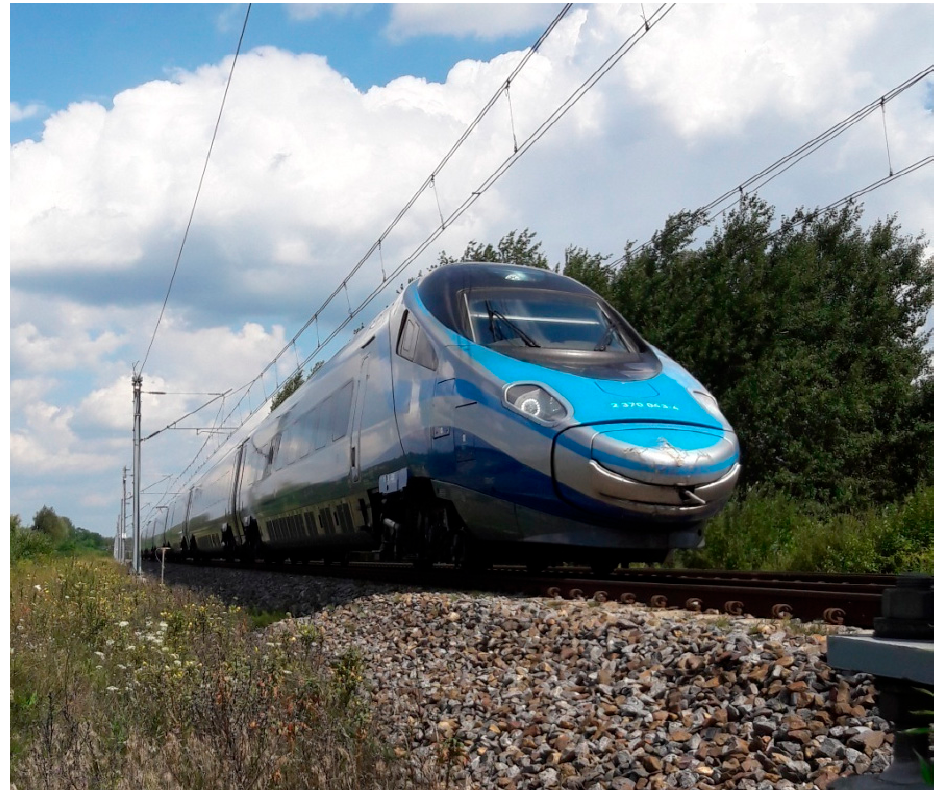
Figure 3. Research object: Alstom vehicle ETR610—ED250 series—Pendolino .